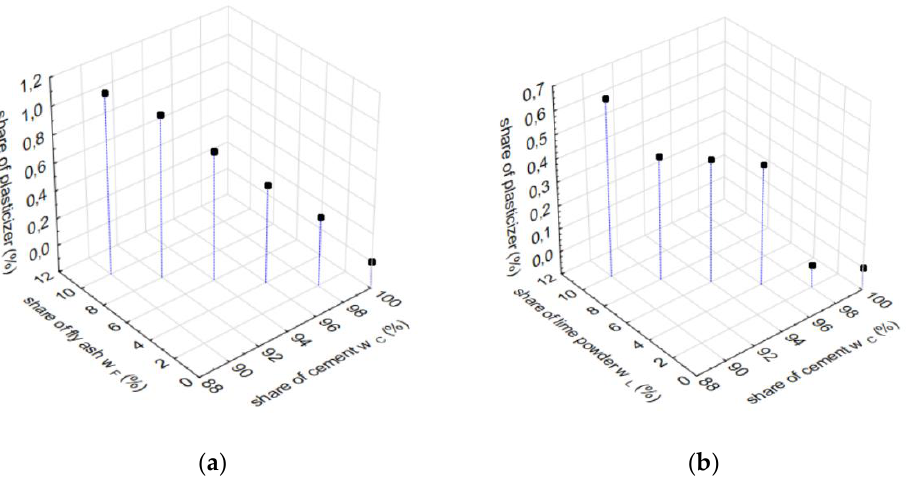
Figure 6. The proportion of plasticizer as a percentage of cement to maintain consistency in mortars modified with ( a ) silica fly ash and ( b ) limestone powder.